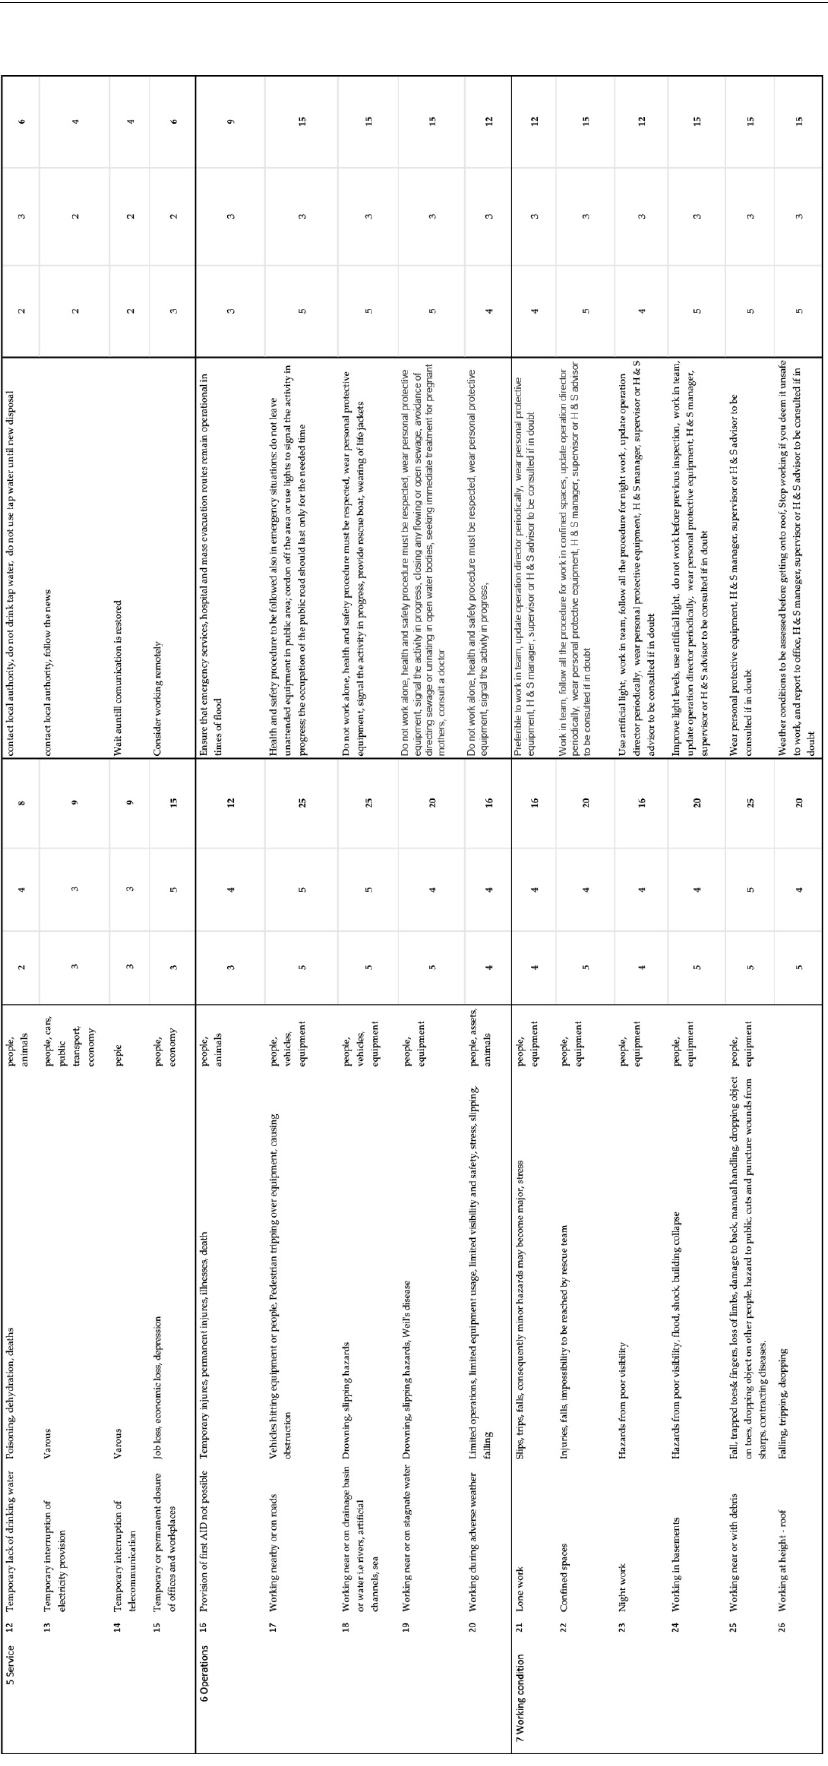
Figure 2. Risk assessment